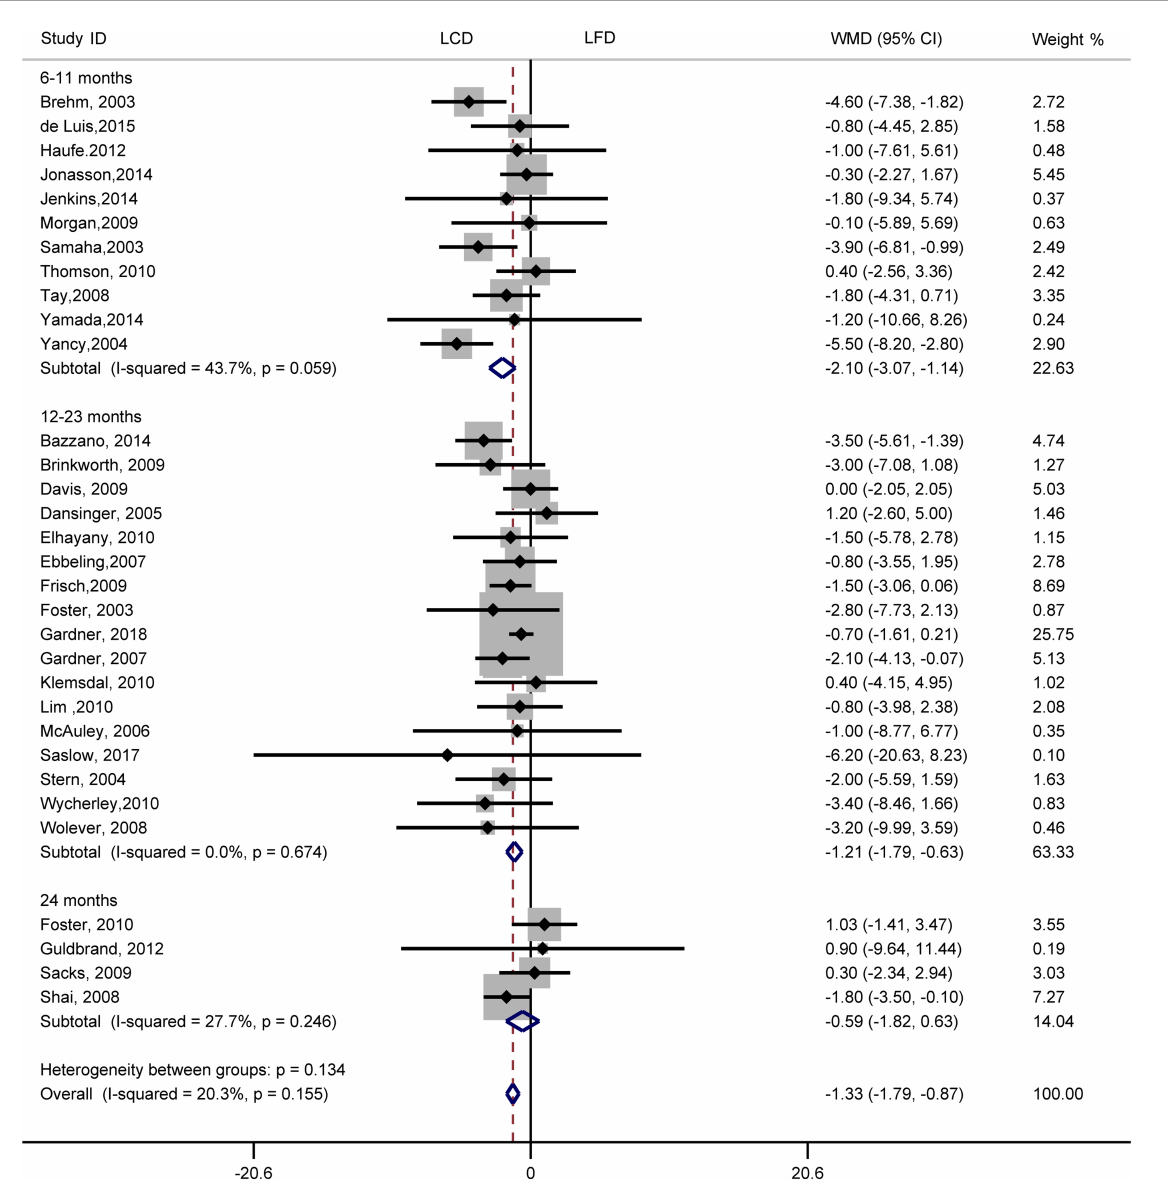
FIGURE7 Forest plots showing weight mean differences (WMD) and 95% CI for weight loss of the low-carbohydrate diets (LCD) in comparison with low-fat diets